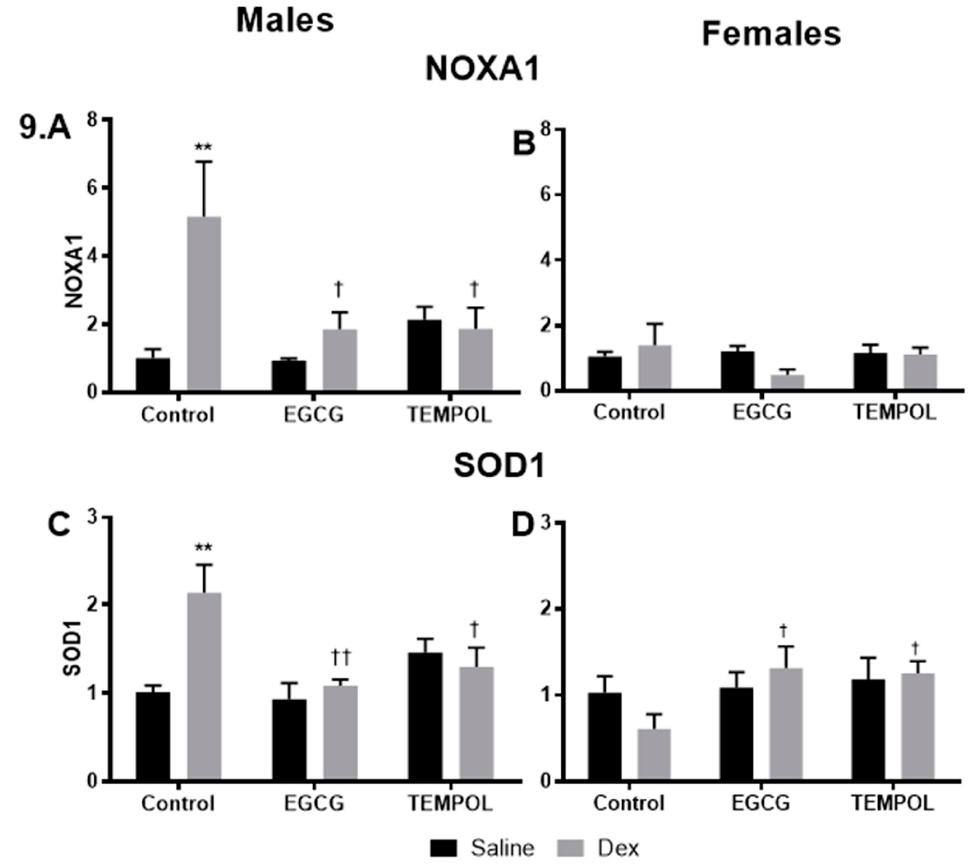
Figure 9. NOXA1 and SOD1 gene expression results from the RT 2 profiler array (Qiagen). Results from the RT 2 profiler array for NADPH oxidase activator 1 (NOXA1) ( A , B ) and superoxide dismutase 1 (SOD1) ( C , D ) for males and females, respectively. Saline and Dex control have been published previously and have been provided for reference [7]. Statistical analysis was performed using a two-way ANOVA (Fisher’s LSD test) shown as † p ≤ 0.05, **/†† p ≤ 0.01. Data are presented as mean ± SEM. Comparison to the Control-Saline group is represented with the symbol (*) and (†) for the Control-Dex offspring. n = 3–5 per group. Significant interactions between maternal injection and antioxidant administration were found for SOD1 males.